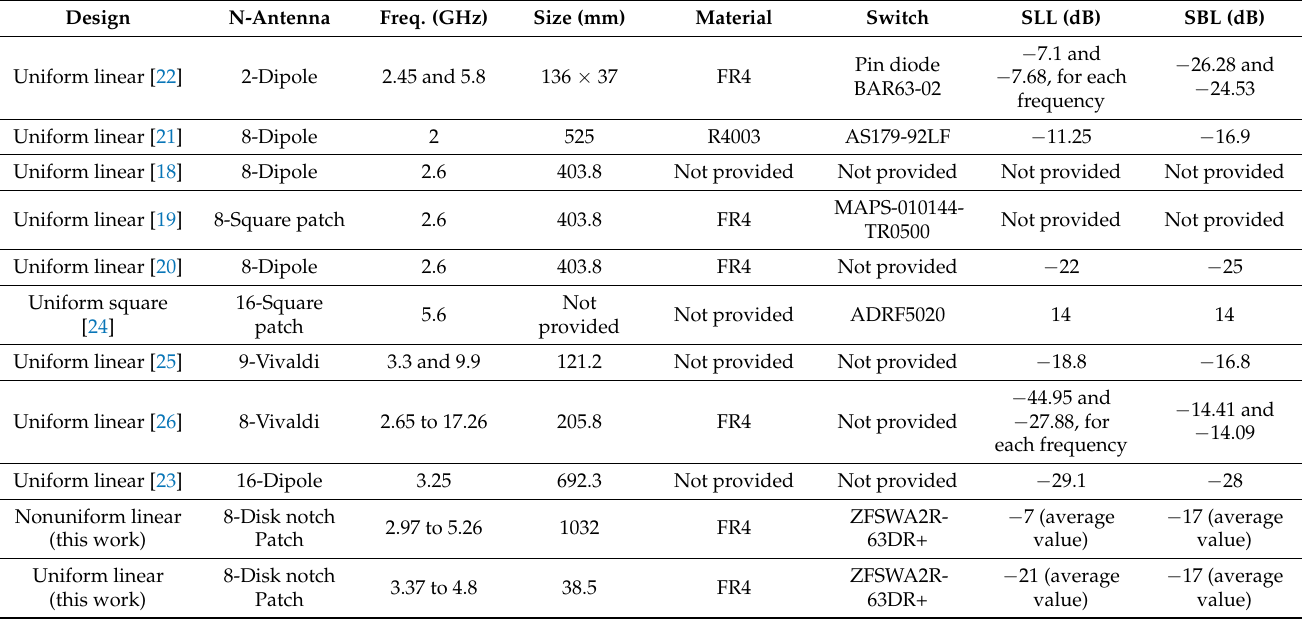
Table 3. Antenna Array Comparison.